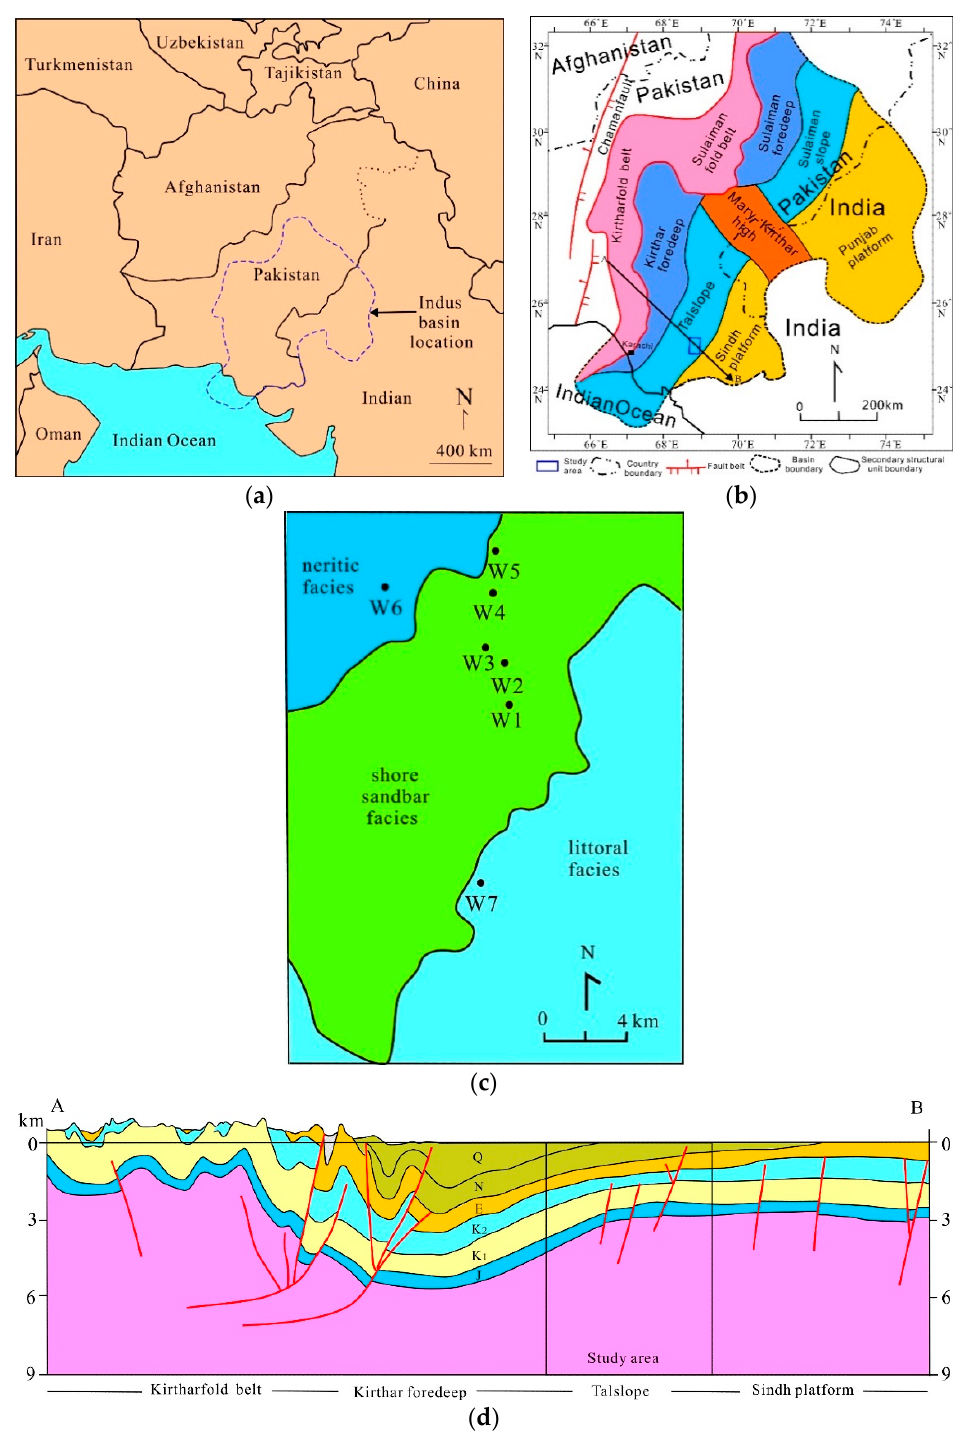
Figure 1. Location and geology of the Indus basin: ( a ) map showing the Indus Basin in southern Pakistan, ( b ) tectonic setting of the Indus Basin and location of the study area, ( c ) Sandbar sedimentary facies and well location map of B member sandbar, ( d ) regional stratigraphic framework from northwest to southeast, and the section location is shown in ( b ) (( d ) is modified by Qian, 2018 [26]).